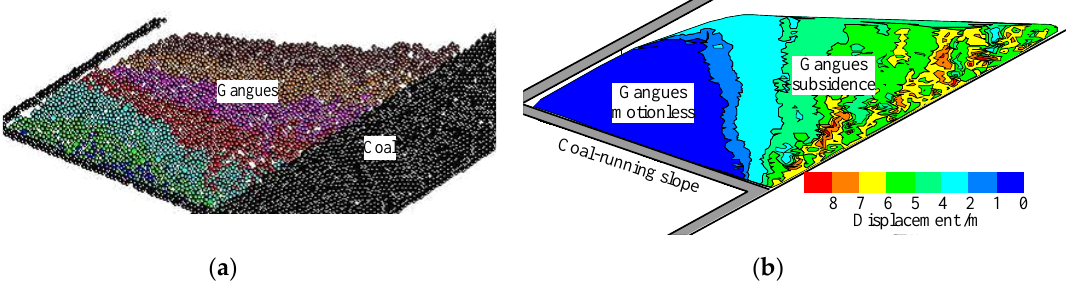
Figure 7. Gangue backfilling characteristics at the small-scale subsidence stage: ( a ) backfilling form and ( b ) displacement distribution.